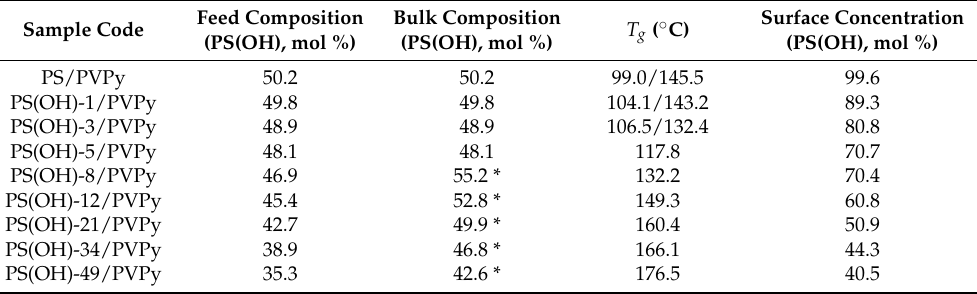
Table 4. Characteristic data of PS(OH)/PVPy blends/complexes [20].